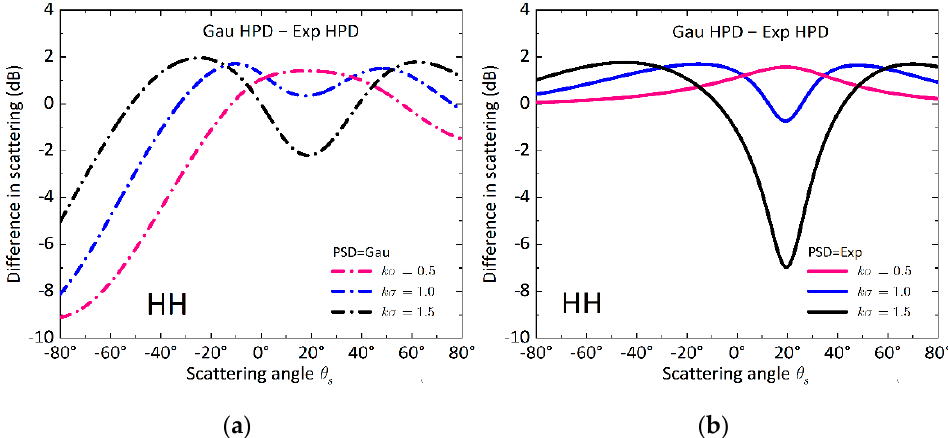
Figure 4. Difference of incoherent scattering as function of scattering angle between the Gaussian and exponential HPD rough surfaces with Gaussian and exponential PSDs at kl = 8, ε r = 15 − j 1.5, θ i = 20 ◦ , φ s = 0 ◦ . ( a ) Gaussian PSD, ( b ) exponential